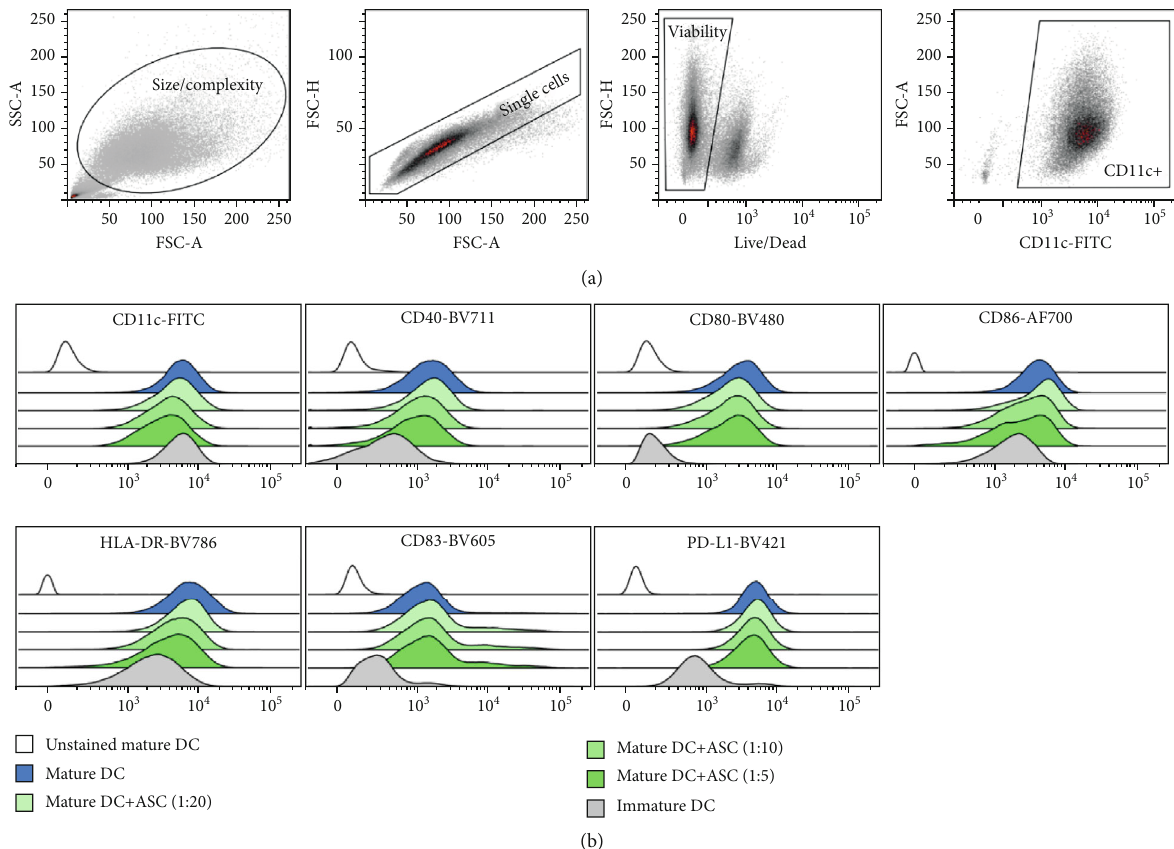
Figure 2: (a) Gating strategy. Sequential gates were set up based on size/complexity, single cells, viability, and CD11c+ events. Analysis of markers was performed on CD11c+ events. (b) Expression of markers. Histograms from a single representative DC donor and ASC donor in di ff erent ratios (ASC:DC ratio from 1:20 to 1